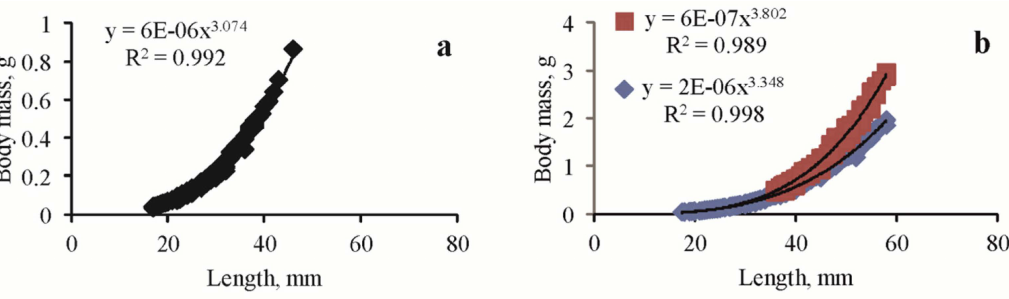
Figure 7. The dependence of body mass on length in Palaemon adspersus in Lake Moynaki: ( a )—males, ( b )—females (squares—with eggs, rhombuses—without